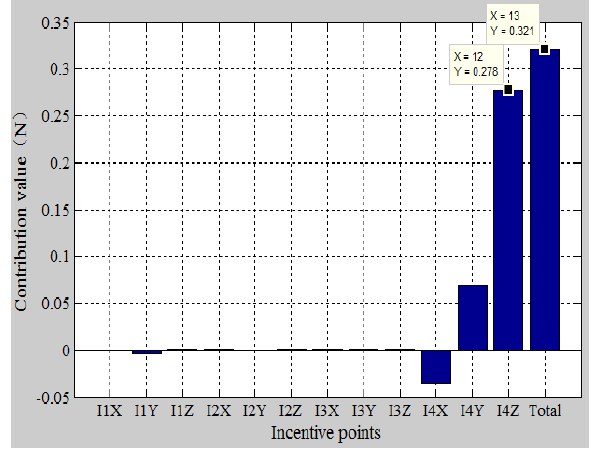
Figure 7. Analysis diagram of Z-direction path contribution of output point O3.